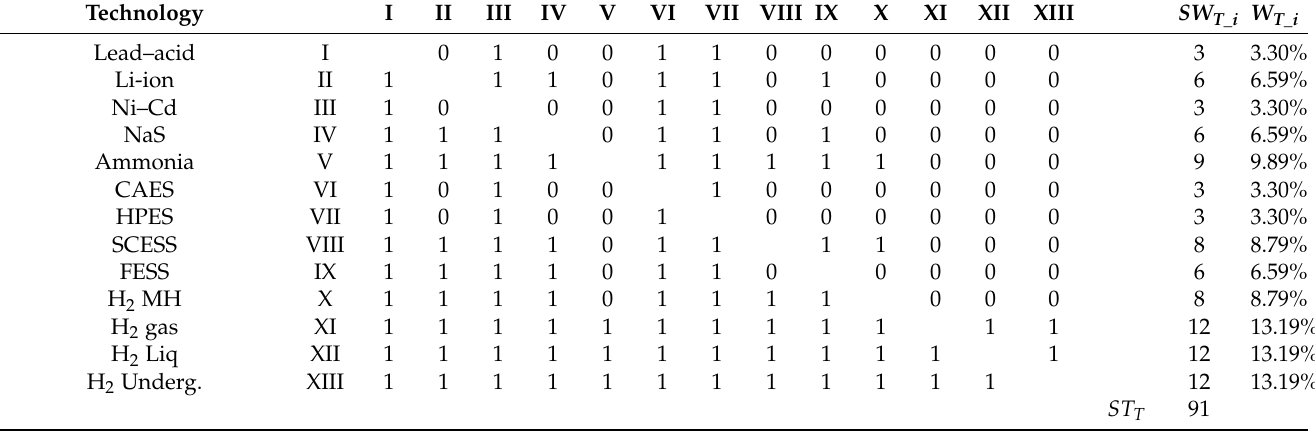
Table A5. Technology comparison matrix for parameter A—mass energy density with